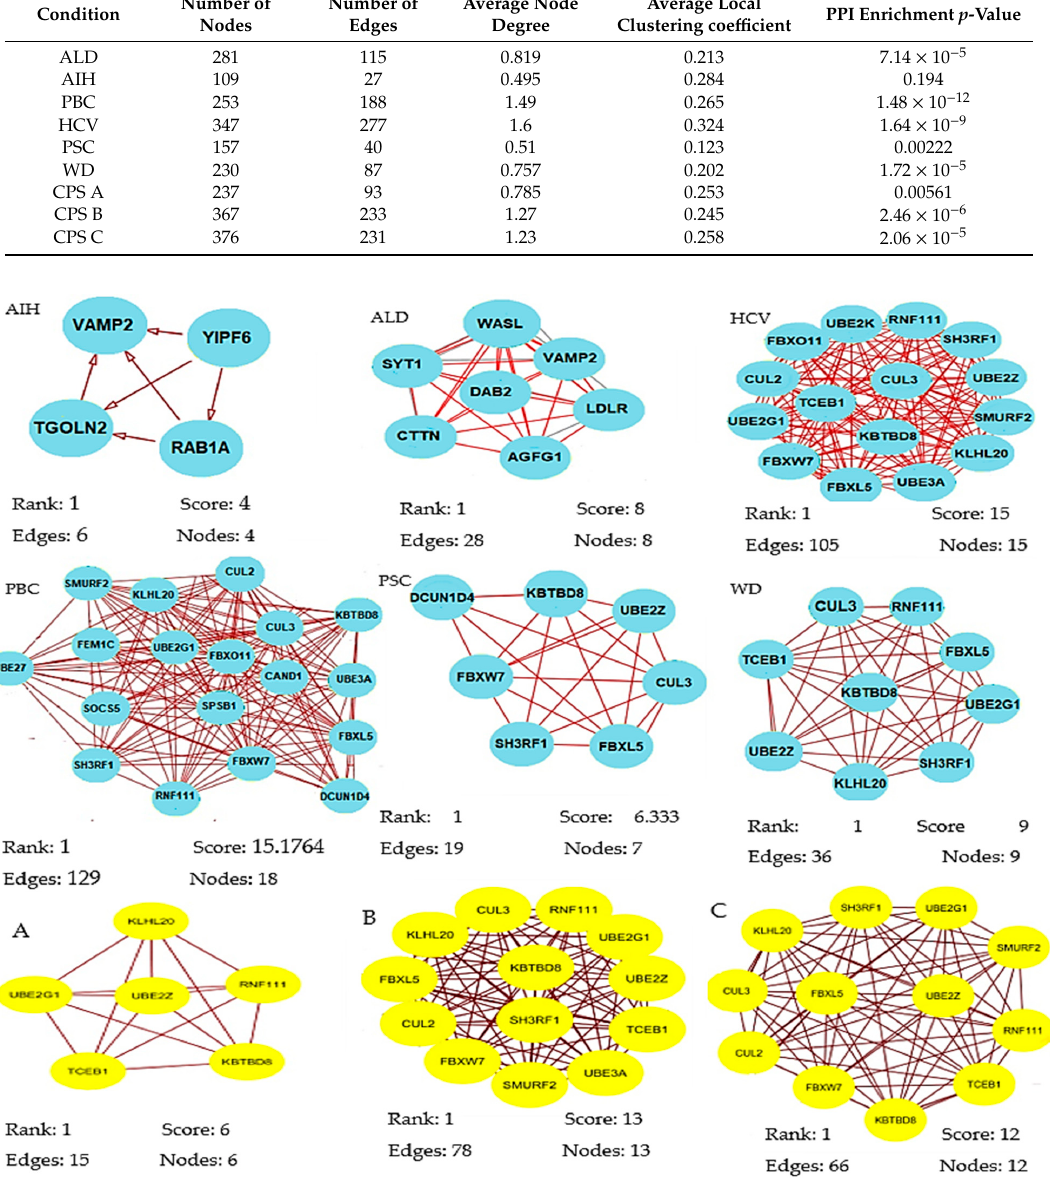
Figure 2. Significant modules of target genes of the differentially expressed miRNAs (DEMs) for each group were obtained from the PPI network using the MCODE plug-in. Rank is based on the cluster’s computed score and is used to identify the clusters within each result. Cluster 1 is the highest ranked cluster in a given result and, thus, at the top of the list. Nodes and edges is are simple enumeration of the cluster’s members and their interconnections. Shown is the top cluster from each condition